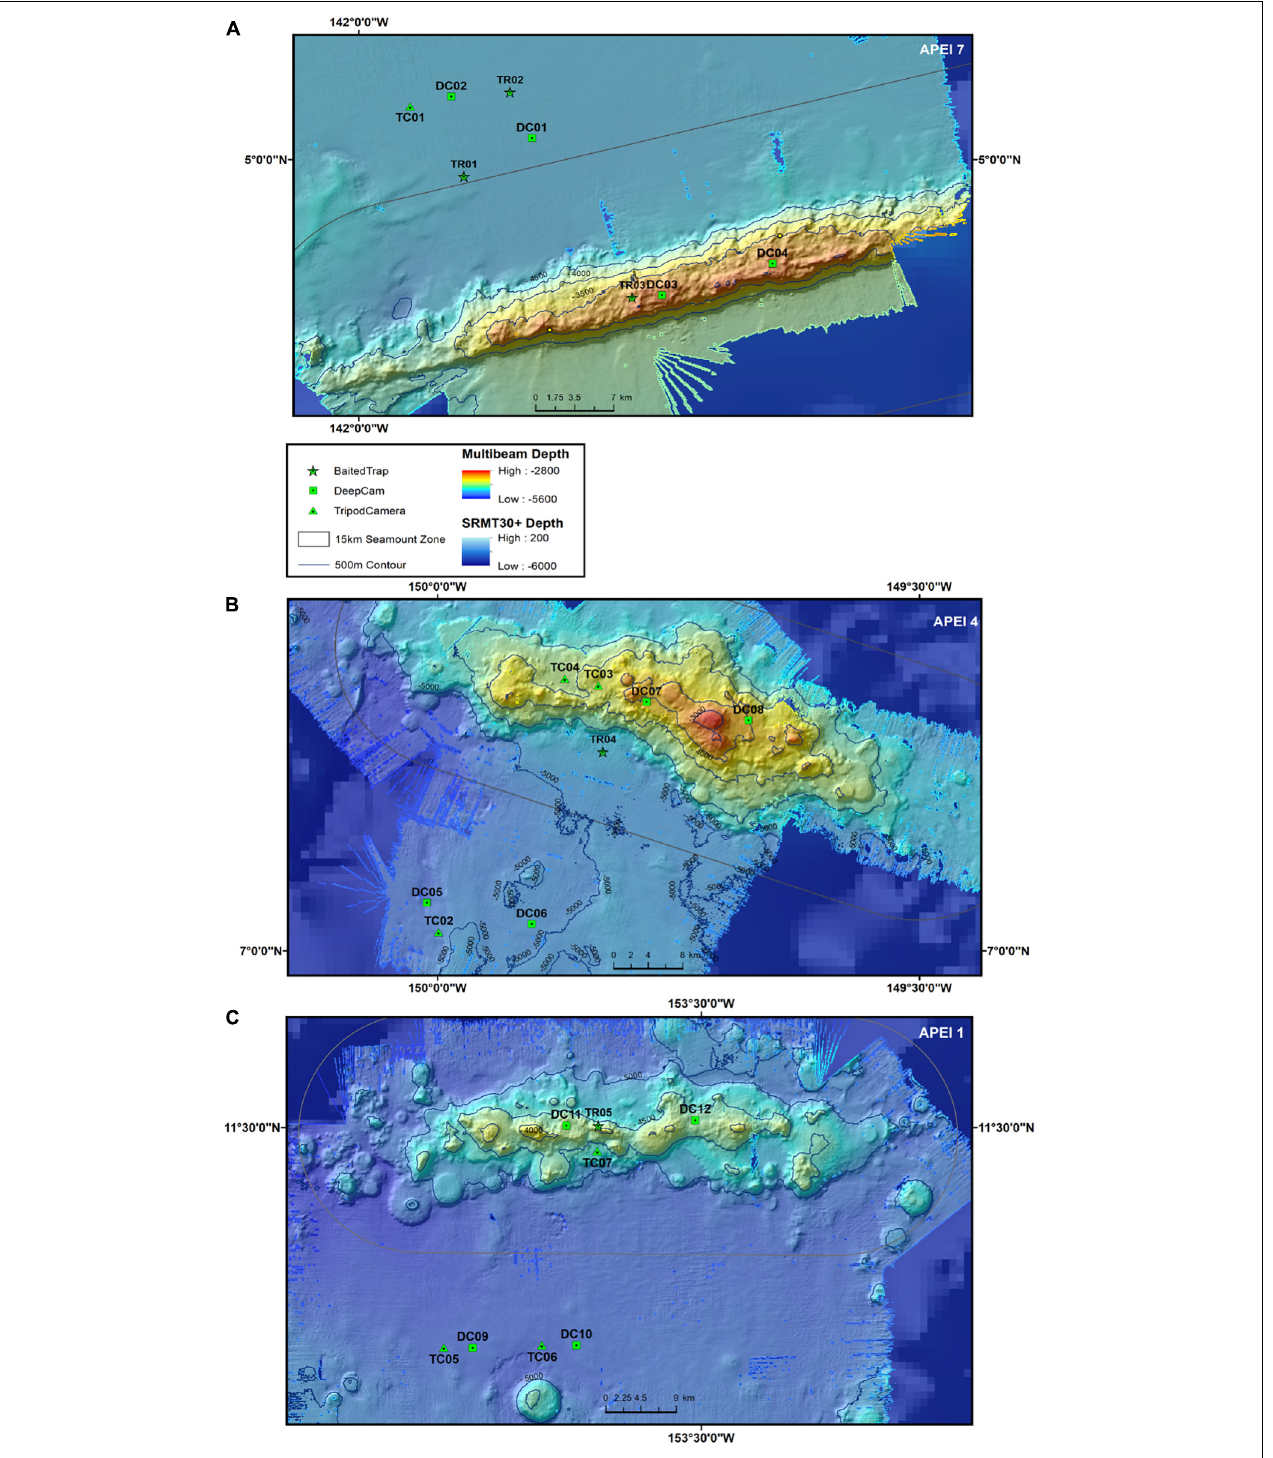
FIGURE 2 | Detailed multibeam bathymetry and sampling locations from three APEIs (A) APEI 7, (B) APEI 4, (C) APEI 1. Baited trap (TR) deployment locations (stars) and baited camera deployment locations [DeepCam lander deployments (DC) as squares, Tripod Camera Lander (TC) as triangles] are shown in each panel. Finer scale multibeam bathymetry (rainbow color scale) overlays coarser satellite-estimated bathymetry (blue, pixelated color scale). The “seamount zone” denoted by a 15 km buffer (as measured from the seamount ridge-line) is shown in gray. Depth contours (500 m) are shown in black. Note TC01 (the first tripod deployment) was not